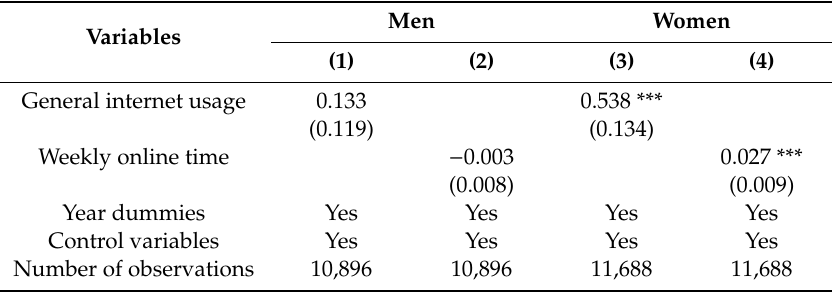
Table 4. Impact of internet use on health outcomes of women and